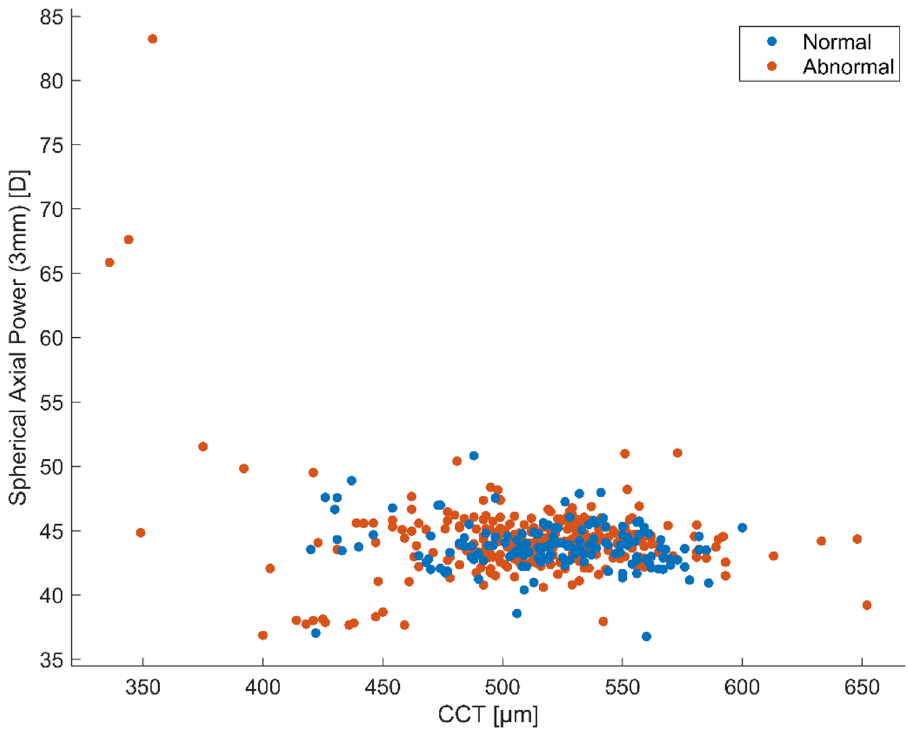
Figure 2. Class distribution of central corneal thickness (CCT) and spherical axial power of normal eyes and eyes with visual field damage.